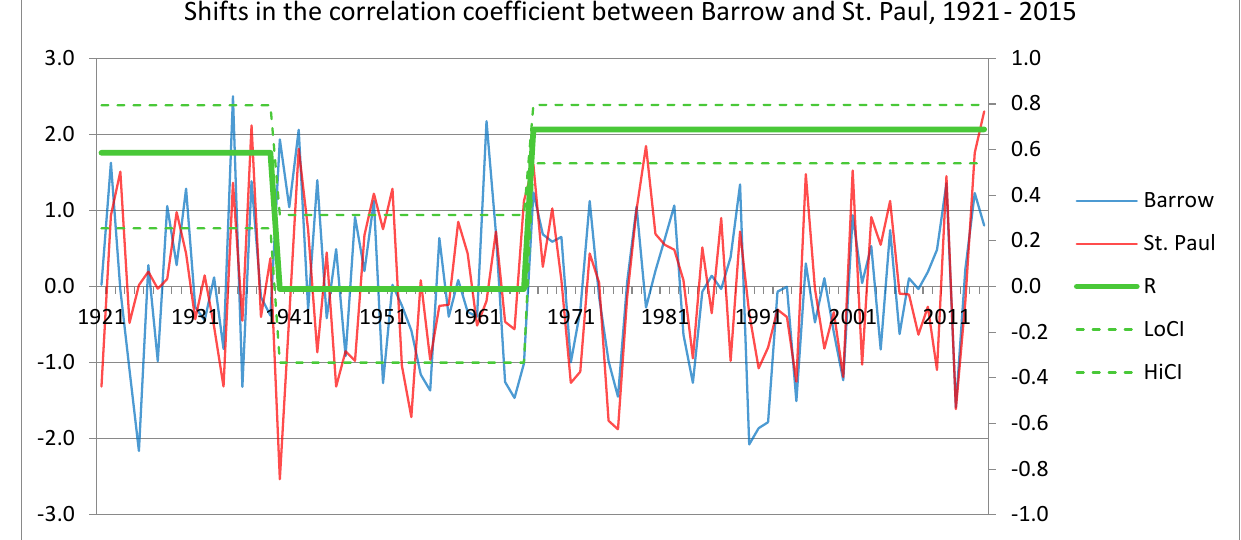
Figure 6. Regime shifts in the correlation coefficient between winter SATs at Barrow and St. Paul detected using the target significance level 𝑝 = 0.1 and cut-off length 𝑙 = 15. The 𝑝 -values for the change-points in 1940 and 1967 are 0.04 and 0.001, respectively. The correlation coefficients, along with their 90% confidence intervals, for the three detected regimes are 0.59 (0.25 − 0.79) for 1921–1939, −0.01 (−0.33 − 0.31) for 1940–1966, and 0.69 (0.54 − 0.80) for